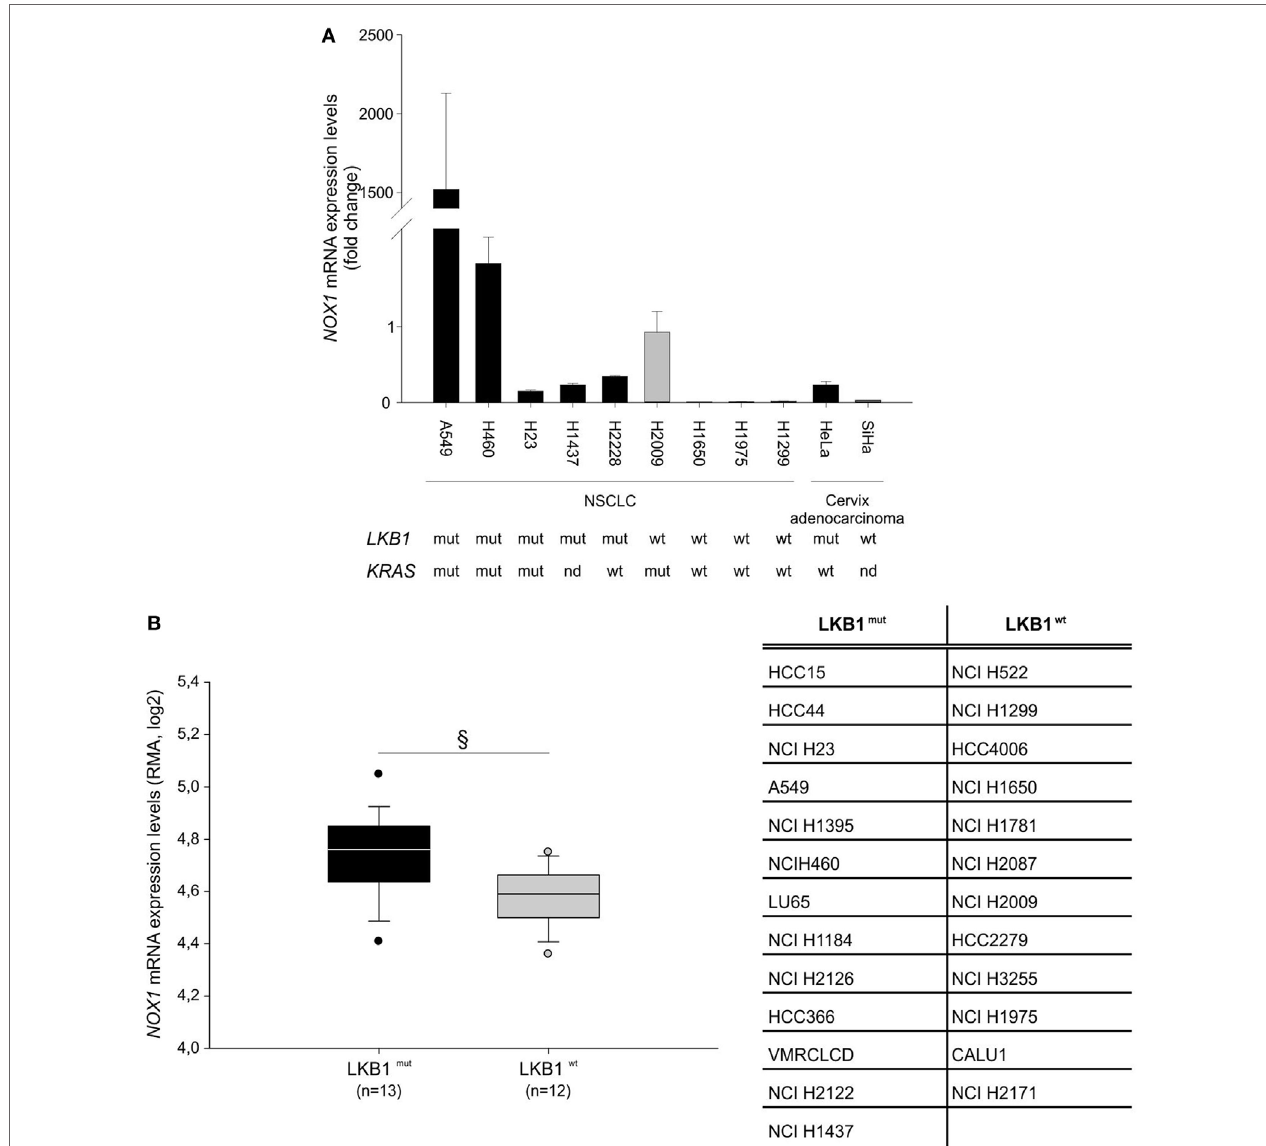
FigUre 2 | Liver kinase B1 (LKB1) controls NADPH oxidase 1 ( NOX1 ) expression in human cell lines. NOX1 expression levels in LKB1-deficient (LKB1 mut ) and LKB1-proficient (LKB1 wt ) non-small cell lung cancer (NSCLC) and cervical cancer cell lines. (a) Expression levels of NOX1 mRNA in NSCLC and cervical cancer cell lines, with defined LKB1 and KRAS mutational statu s. Results are reported as mean value ± SD of three independent experiments and are expressed as fold change compared to H2009 cells, arbitrary set at 1. (B) In silico analysis of NOX1 levels in NSCLC cell lines. Expression level of NOX1 as Robust Multi-array Average (RMA) values (source: Cancer Cell Line Encyclopedia). The dispersion of NOX1 expression values in n = 13 LKB1 mutated and in n = 12 LKB1 wild-type cancer cell lines is represented as box-plots, indicating the first and the third quartiles and the median. The list of LKB1 -mutated and non-mutated cancer cell lines is reported in the table ( § P < 0.05). nd = mutational status not